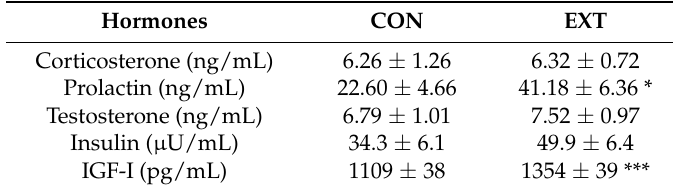
Table 2. Hormonal circulating concentrations in rats after 14 days of habitual (CON) and extended (EXT) light–dark conditions (respectively 12:12 h and 16:8 h).